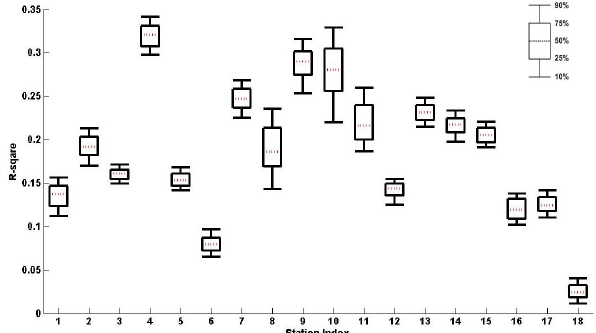
Figure 3: Box-plot of R 2 (based on equation (3)) of principal component regression (PCR) model Fig. 3. Box plot of R 2 (based on Eq. 3) of principal compo- predicted TN loadings obtained using PC’s of forecasted precipitation under leave-one-out cross nent regression (PCR) model predicted TN loadings obtained using validation (LCV). PCs of forecasted precipitation under leave-one-out cross validation (LCV).